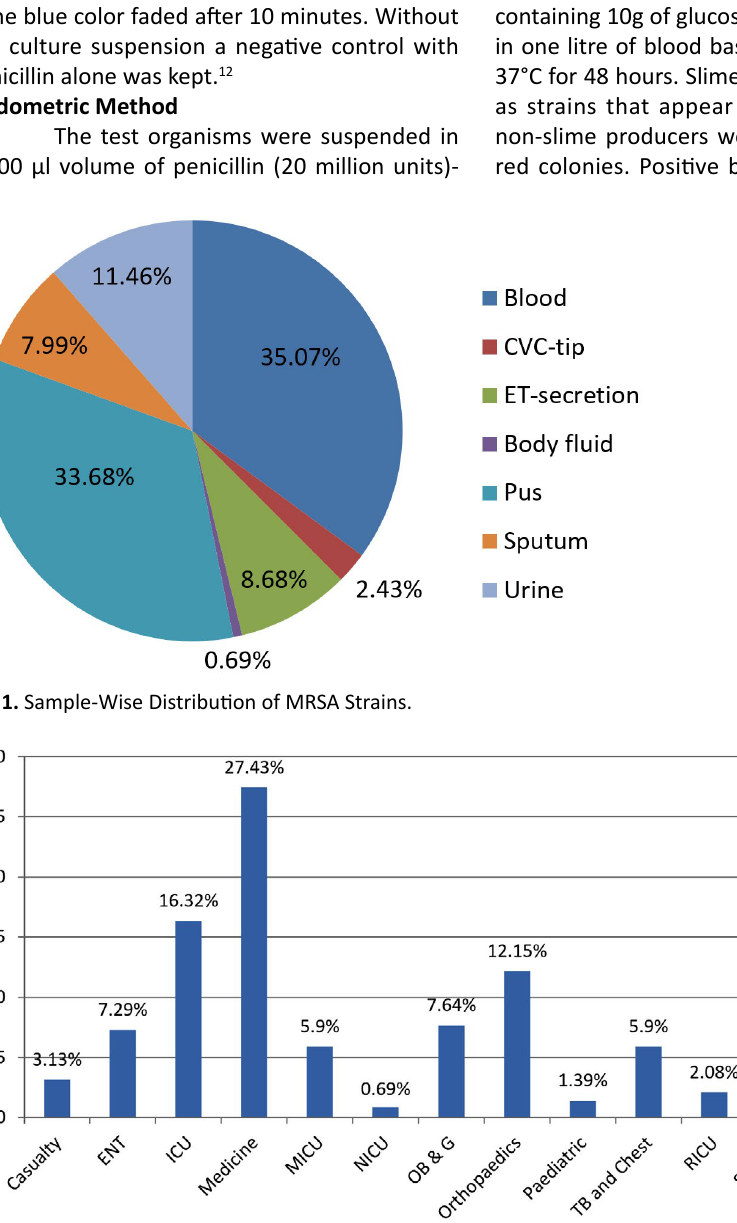
Fig. 2. Department-Wise Distribution of MRSA